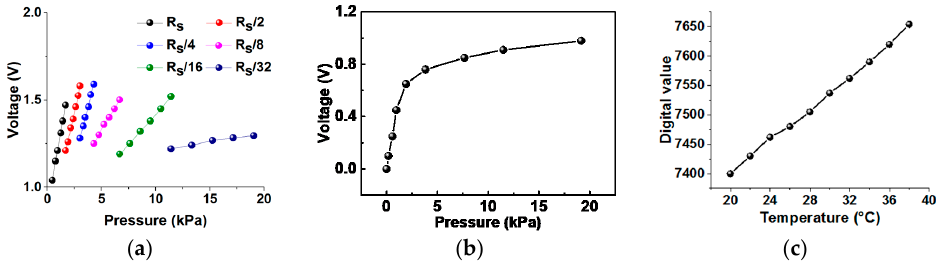
Figure 6. Sensor readout characteristics after triple-mode signal process: ( a ) P mode; ( b ) Q mode; ( c ) T mode.